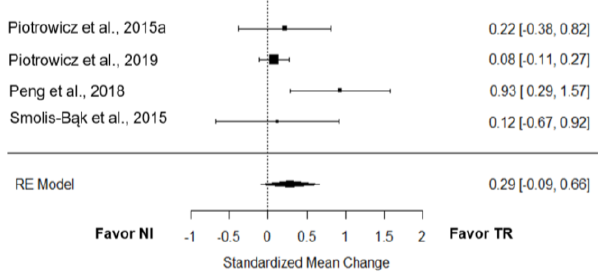
Figure 3. Effect of TR on the 6MWD compared to NI [21,22,24,28].